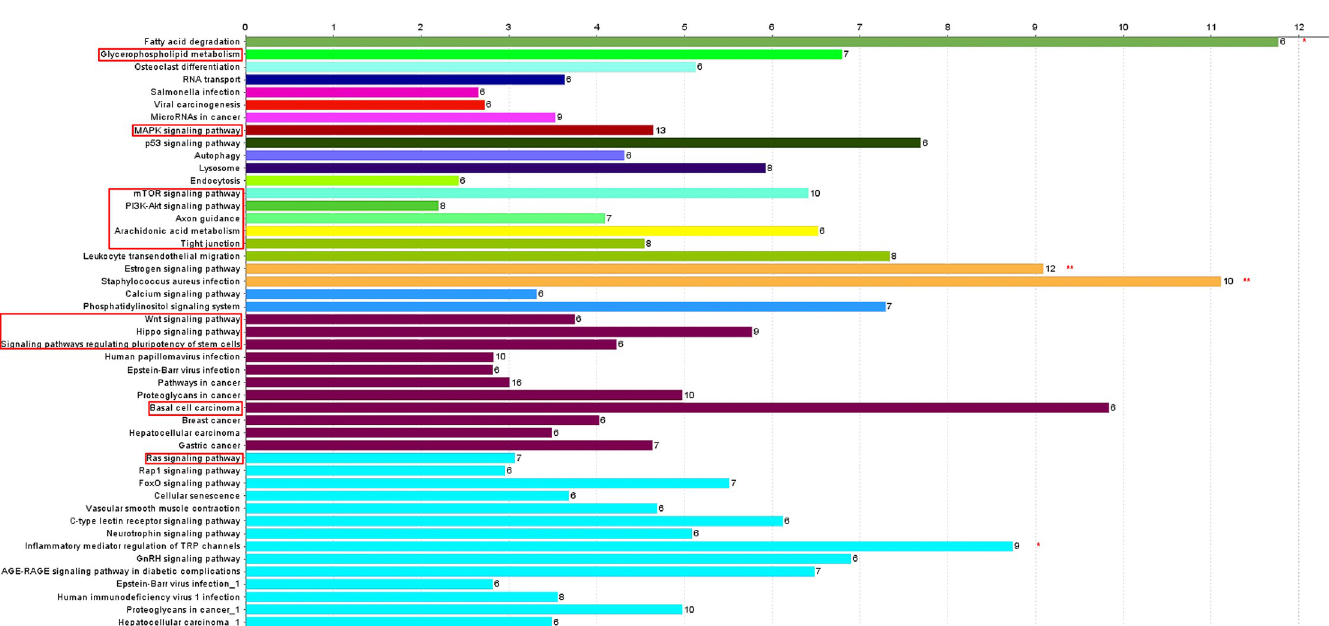
Fig 9. KEGG signal pathway enrichment diagram. Abscissa indicates percentage of genes enriched by each signaling pathway relative to total genes of each signaling pathway; numbers to right of columns indicate number of genes enriched by each signaling pathway; red boxes: Signaling pathways involved in development of skin hair follicles. � P < 0.05, �� P <